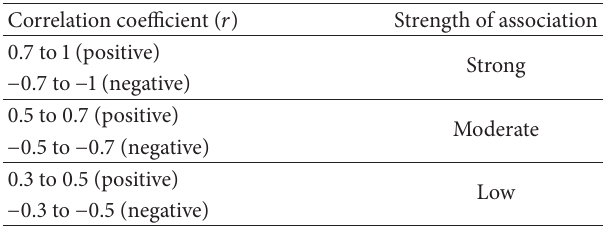
Table 1: Comparative description of correlation coefficient ( 𝑟 ) and strength of